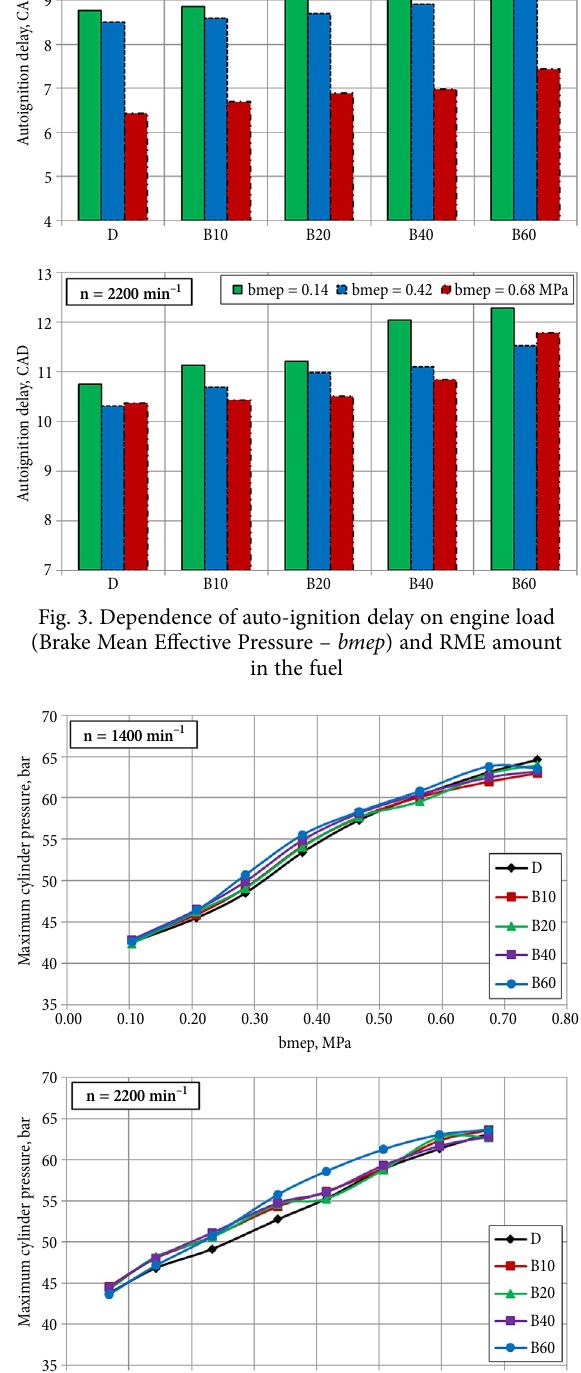
Table 2. The accuracy of measured emission parameters Measurements Accuracy NO x ±5 ppm